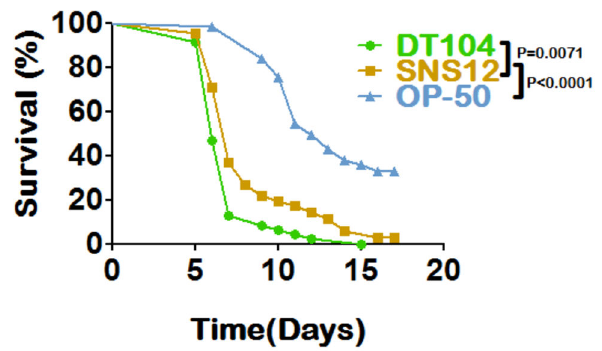
Figure 1. Salmonella Typhimurium DT104 kills C. elegans significantly faster when MDR genes are present. L4 stage